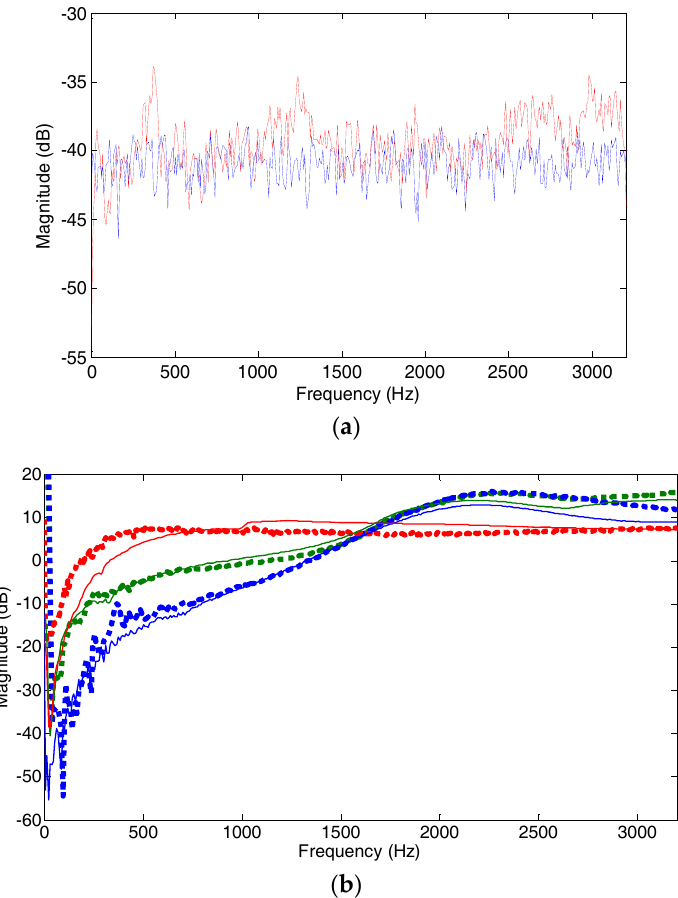
Figure 5. Magnitude responses, ( a ) the recorded rain sound (red line) and white noise (blue line), ( b ) results of ˆ S ( z ) using white noise (solid) and natural sound (dotted) for the in-ear (red), earbud (blue), and clip earphones (green).